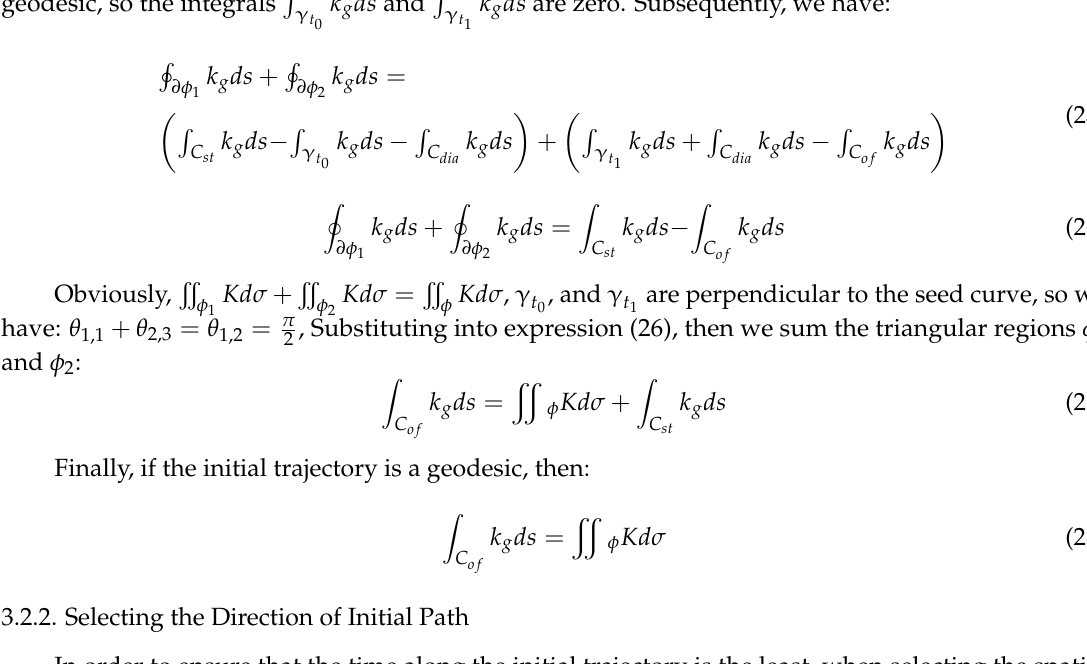
Figure 6. The Relationship between the Curvature Integral of Geodesic Surface and the Gaussian